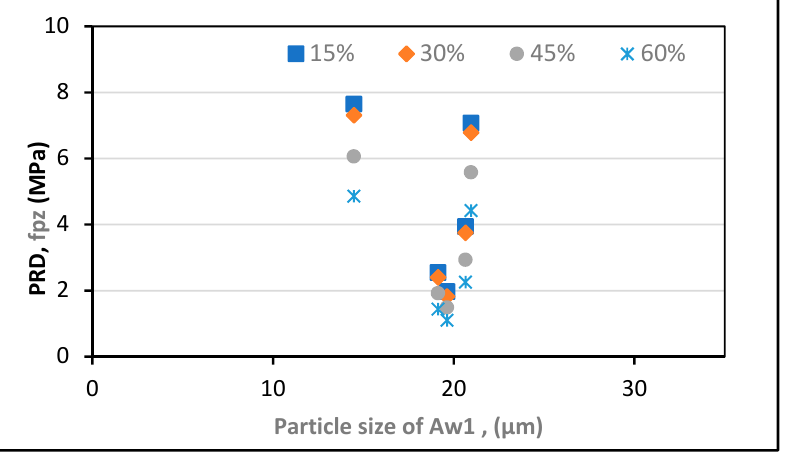
Figure 6. Discrepancy trends of pozzolanic reactions of RHA with BET SSA and the percentage of additives. Figure 7. Discrepancy trends of pozzolanic involvement of RHA with different percentages at var- ying particle diameters.